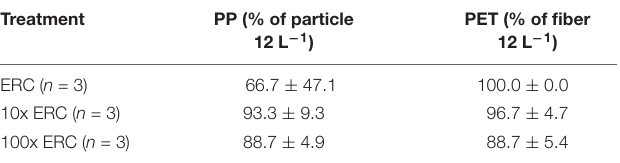
TABLE 3 | Percentage (mean ± standard deviation) of microplastic recovery rates of from spike-recovery test in three treatment groups during single exposure of adult damselfish Pomacentrus amboinensis to blue polypropylene (PP) particles and polyethylene (PET) fibers in our controlled laboratory experiment.